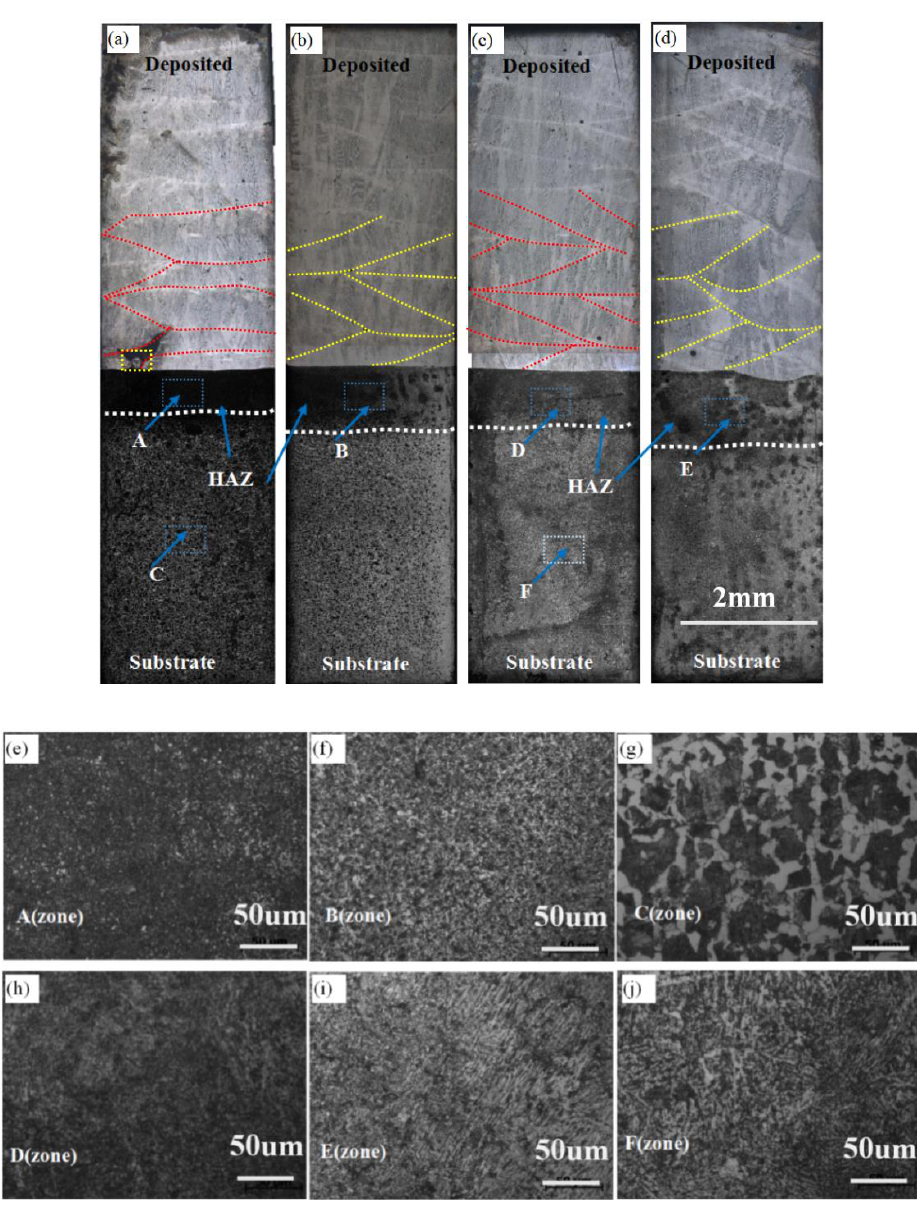
Figure 4. Optical macrograph showing the morphologies on the transverse cross section of ( a ) 316 L with 1045 without preheating, ( b ) 316 L with P20 without preheating, ( c ) 316 L with 1045 preheated to 200 °C, ( d ) 316 L with P20 preheated to 200 °C; microstructure of A zone ( e ), B zone ( f ), C zone ( g ), D zone ( h ), E zone ( i ), F zone ( j ).